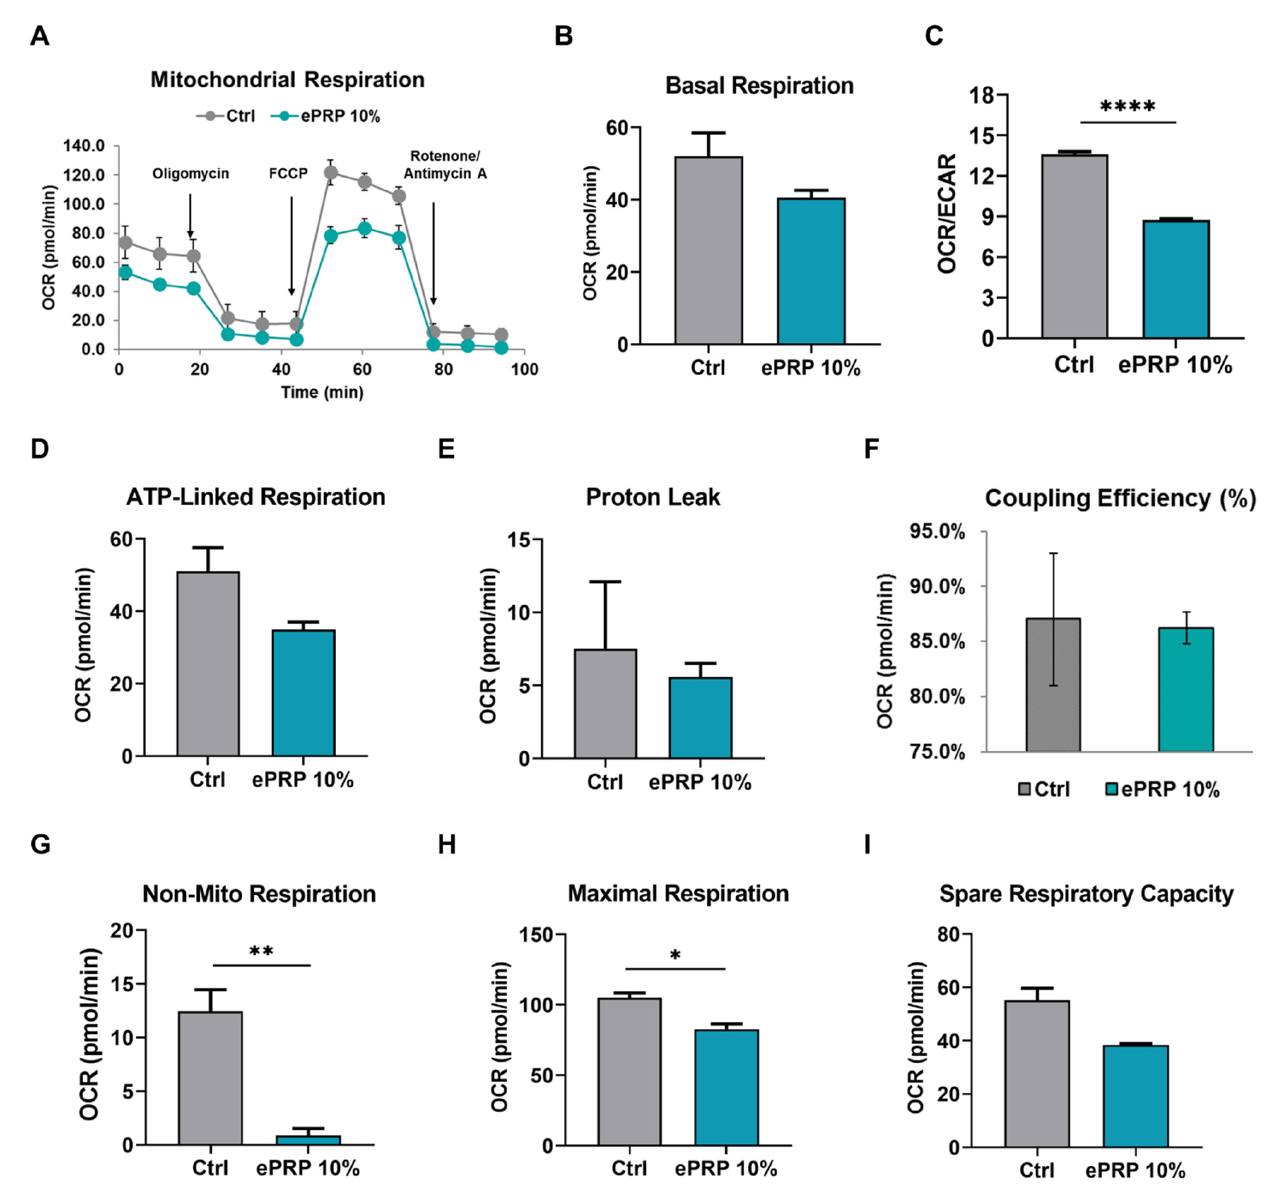
Figure 6. Mitochondrial function in fibroblasts is altered after exposure to ePRP. ( A ) All cells were treated with oligomycin, FCCP, and rotenone/antimycin A to quantify OCR and ECAR. A representative Seahorse Cell Mito Stress Test analysis with computable parameters. Values for the following respiratory parameters were determined. ( B ) Basal respiration. ( C ) OCR/ECAR. ( D ) ATP-linked respiration. ( E ) Proton leak. ( F ) Coupling efficiency (%) ( G ) Non-mitochondrial respiration. ( H ) Maximal respiration. ( I ) Mitochondrial spare respiratory capacity. * p < 0.05, ** p < 0.01, **** p < 0.0001 depicts that the groups differ